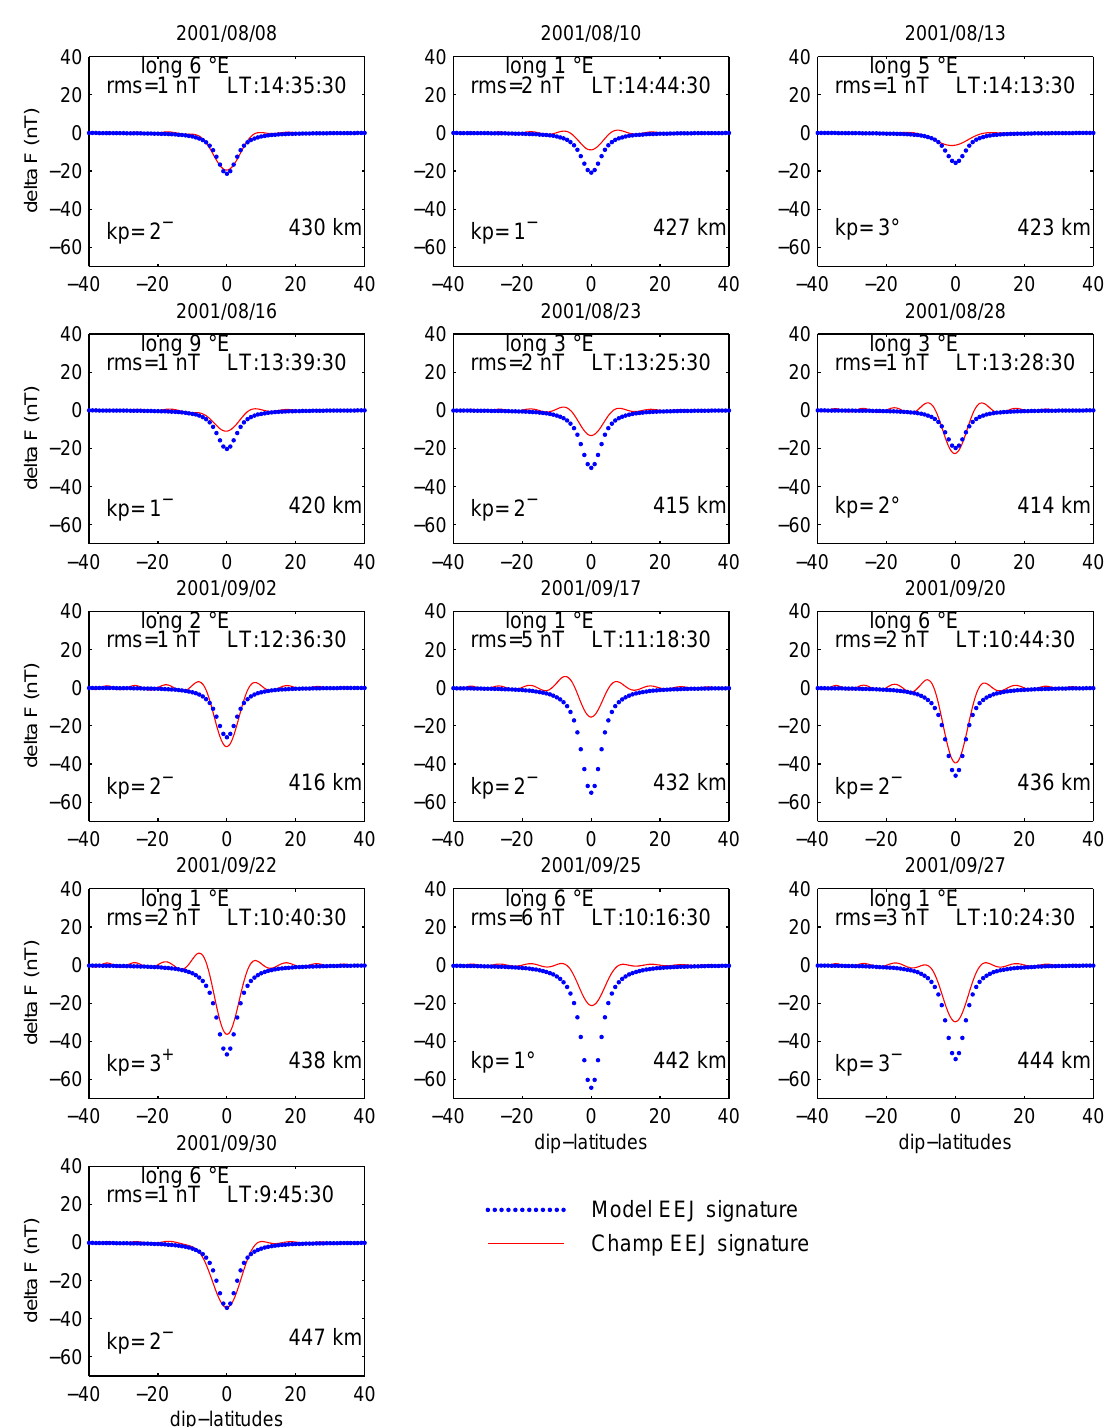
Fig. 6. Comparison between the CHAMP satellite magnetic signature and the modeled magnetic effects of the EEJ. The 3EM magnetic effects extrapolated at CHAMP satellite altitude (blue dotted line) are compared with the overhead CHAMP EEJ signatures (red solid line). The modeled profiles were computed using ground-based EEJ parameters deduced from data recorded in West Africa. The altitude, longitude, local time and the rms are